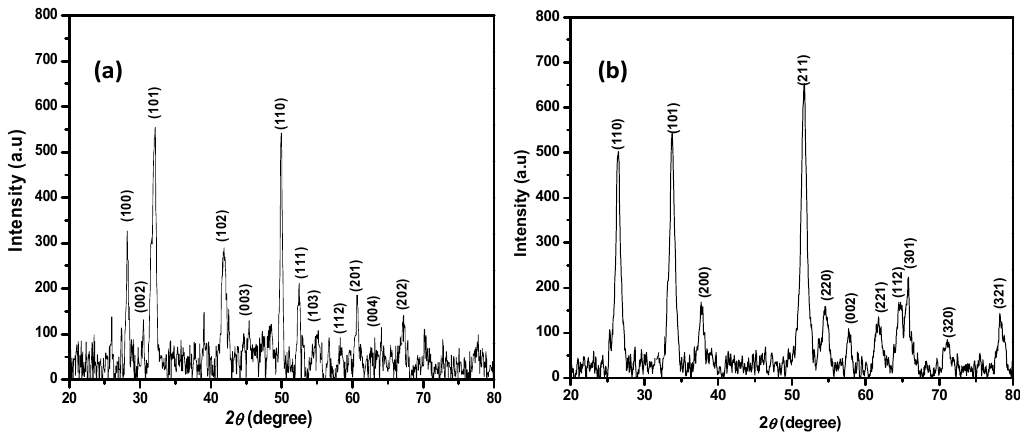
Figure 3. The obtained XRD pattern of ( a ) SnS 2 and ( b ) SnO 2 synthesized from diphenyltin(IV) p - methylphenyldithiocarbamate.